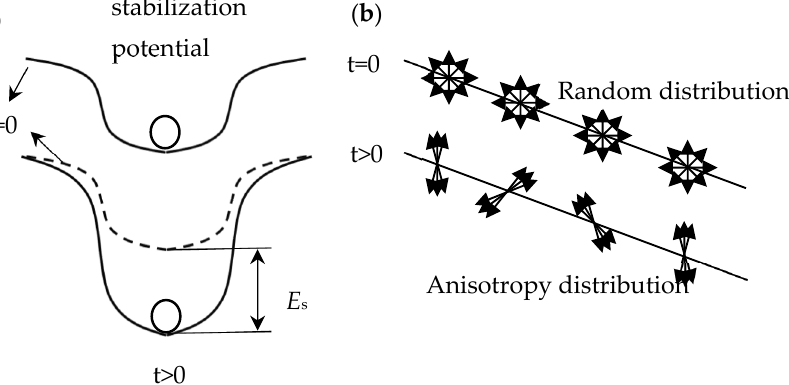
Figure 9. Diagram of the formation of the stabilization potential of the domain wall over time ( a ), diagram of the model of the magnetic delay phenomenon caused by the reorientation of the axis of pairs of atoms inside the domain wall ( b ) [24].